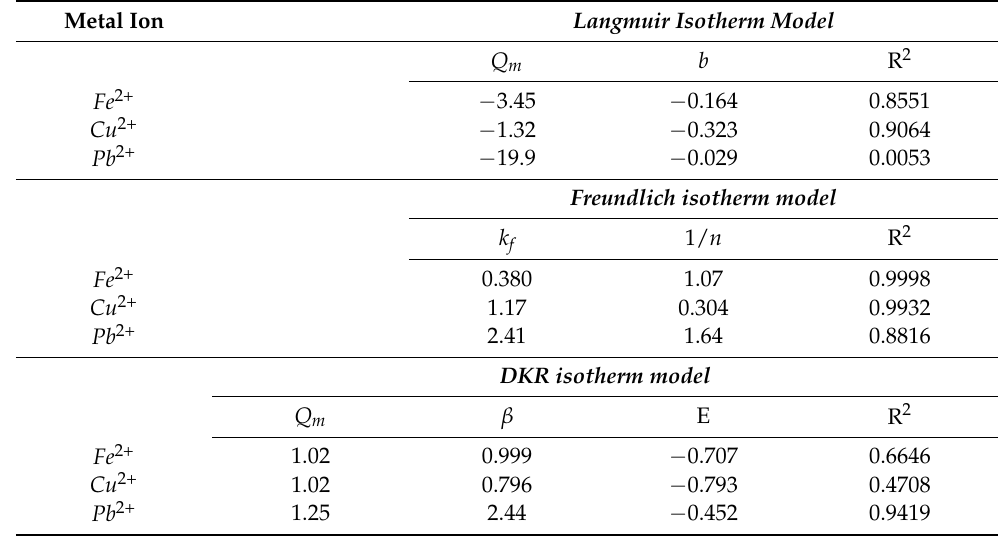
Table 1. The isothermal constants of the three models Langmuir, Freundlich, and DKR.